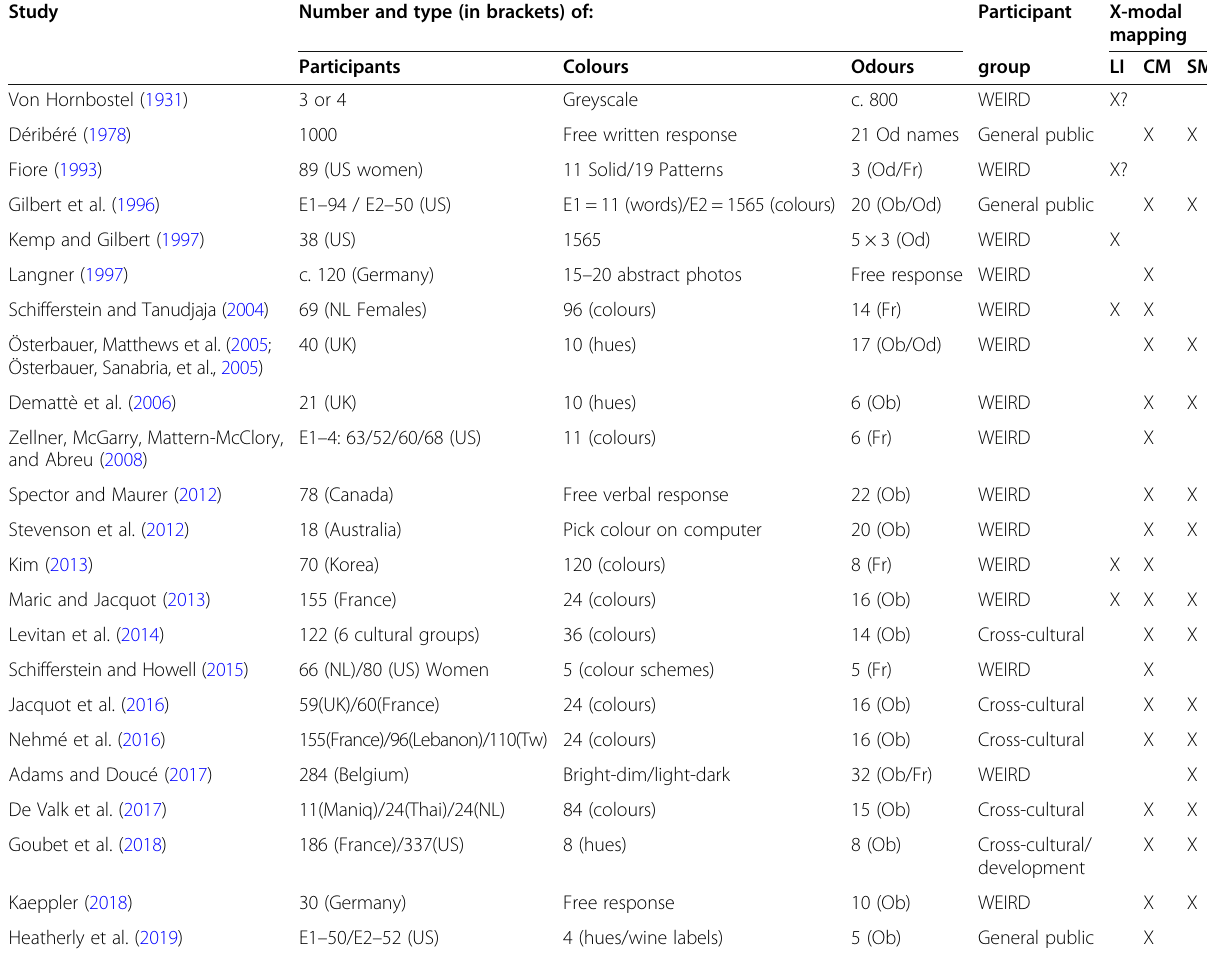
Table 1 Summary of peer-reviewed published studies that have demonstrated a consistent (i.e. non-random) crossmodal mapping of colours to odours (or vice versa; see Langner, 1997). While the number and type of olfactory stimuli, the number and type of visual stimuli, and the participant demographics have varied widely between studies, all have demonstrated the existence of crossmodal correspondence between colours and odours. The precise nature of the mapping, though, often varies from one study/ participant sample to another. Note that certain studies have chosen to match olfactory stimulus intensity, whereas others have deliberately chosen to vary perceived olfactory intensity. The various studies listed in the table also vary in terms of whether the olfactory stimuli were easily associated with a source object or not. WEIRD is the acronym used to refer to Western, Educated, Industrialized, Rich, and Democratic undergraduate participants (very often psychology students) who constitute the subject pool for the majority of experimental psychology research (e.g. Arnett, 2008; Henrich et al.,